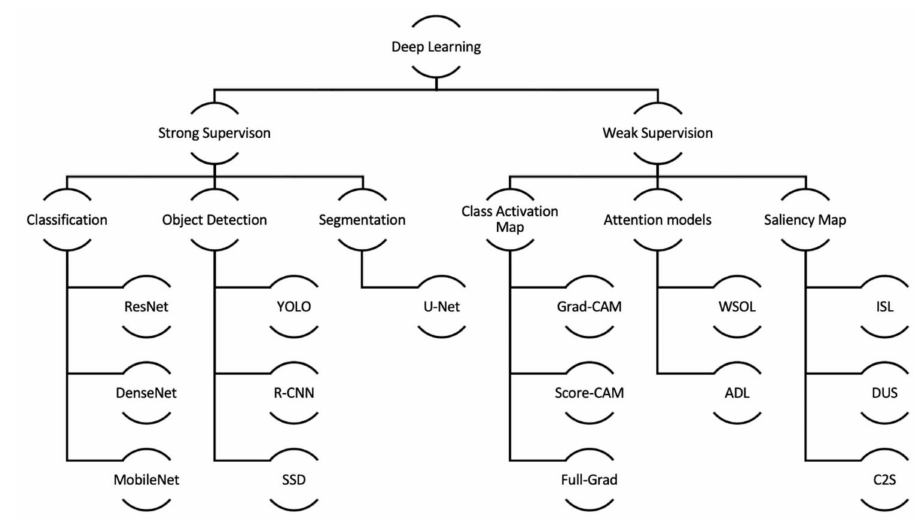
Figure 8. Taxonomy of Localization Approaches within Deep